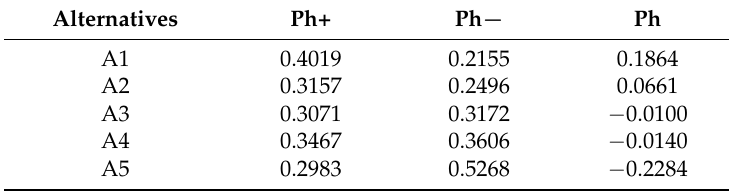
Table 11. PROMETHEE